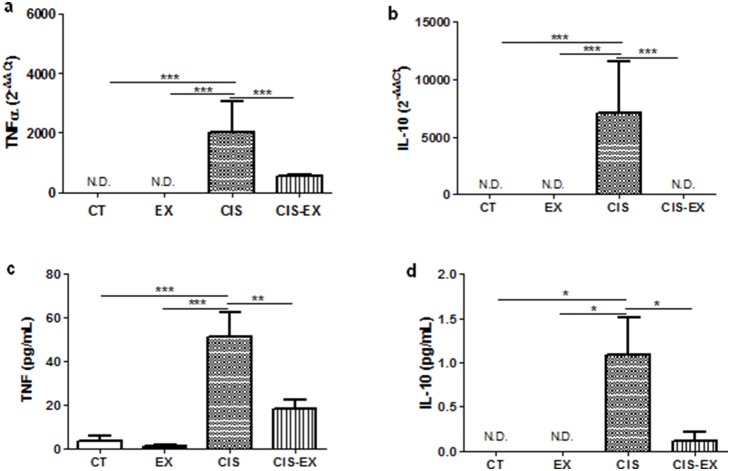
Exercise attenuates inflammation.qPCR analysis revealed that the CIS group showed higher expressions of TNF (A) and IL-10 (B) in the kidney, while CIS-EX did not exhibit significant differences compared to CT. The serum concentrations of TNF (C) and IL-10 (D), determined by CBA, appeared to decrease in the CIS-EX group. *P<0.05; **P<0.01; ***P<0.001; N.D. - non detected cytokine.